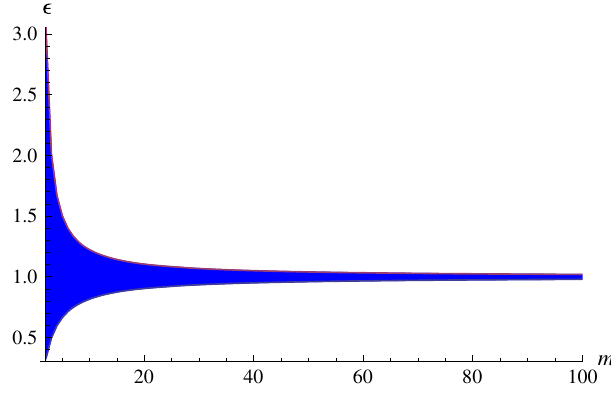
; ϵ (cid:3) (cid:4) for which (cid:3) ~ β 1 Þ = ~ β 1 Þ ¼ m cos ð π = 2 m Þ = Q ð C ð